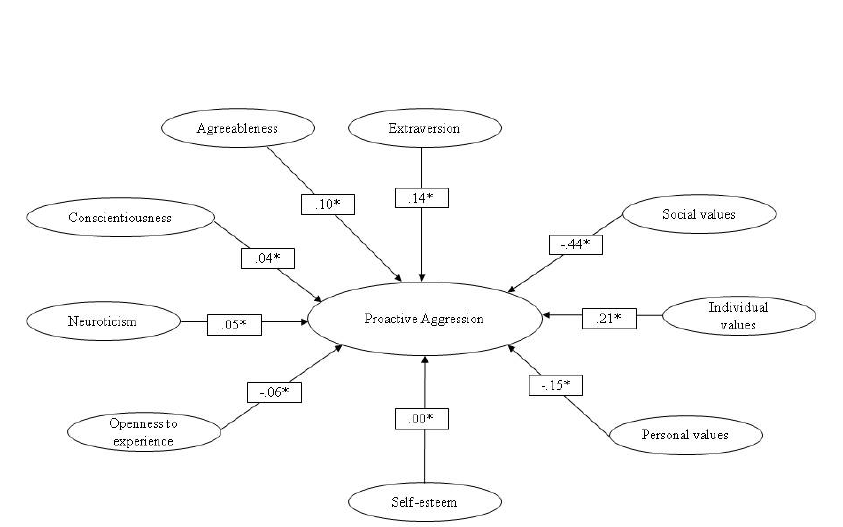
Figure 2. Structural equation model for proactive aggression (involvement) using personality, values, and self-esteem